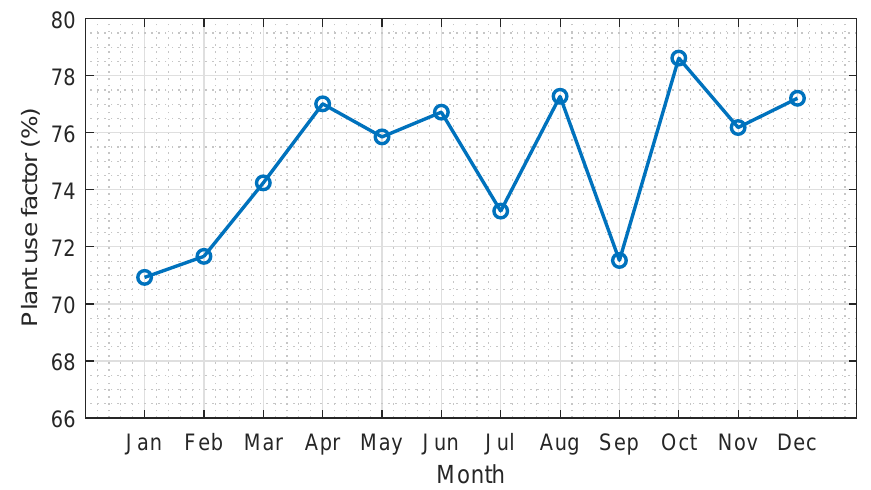
Figure 8. Variation of plant use factor by